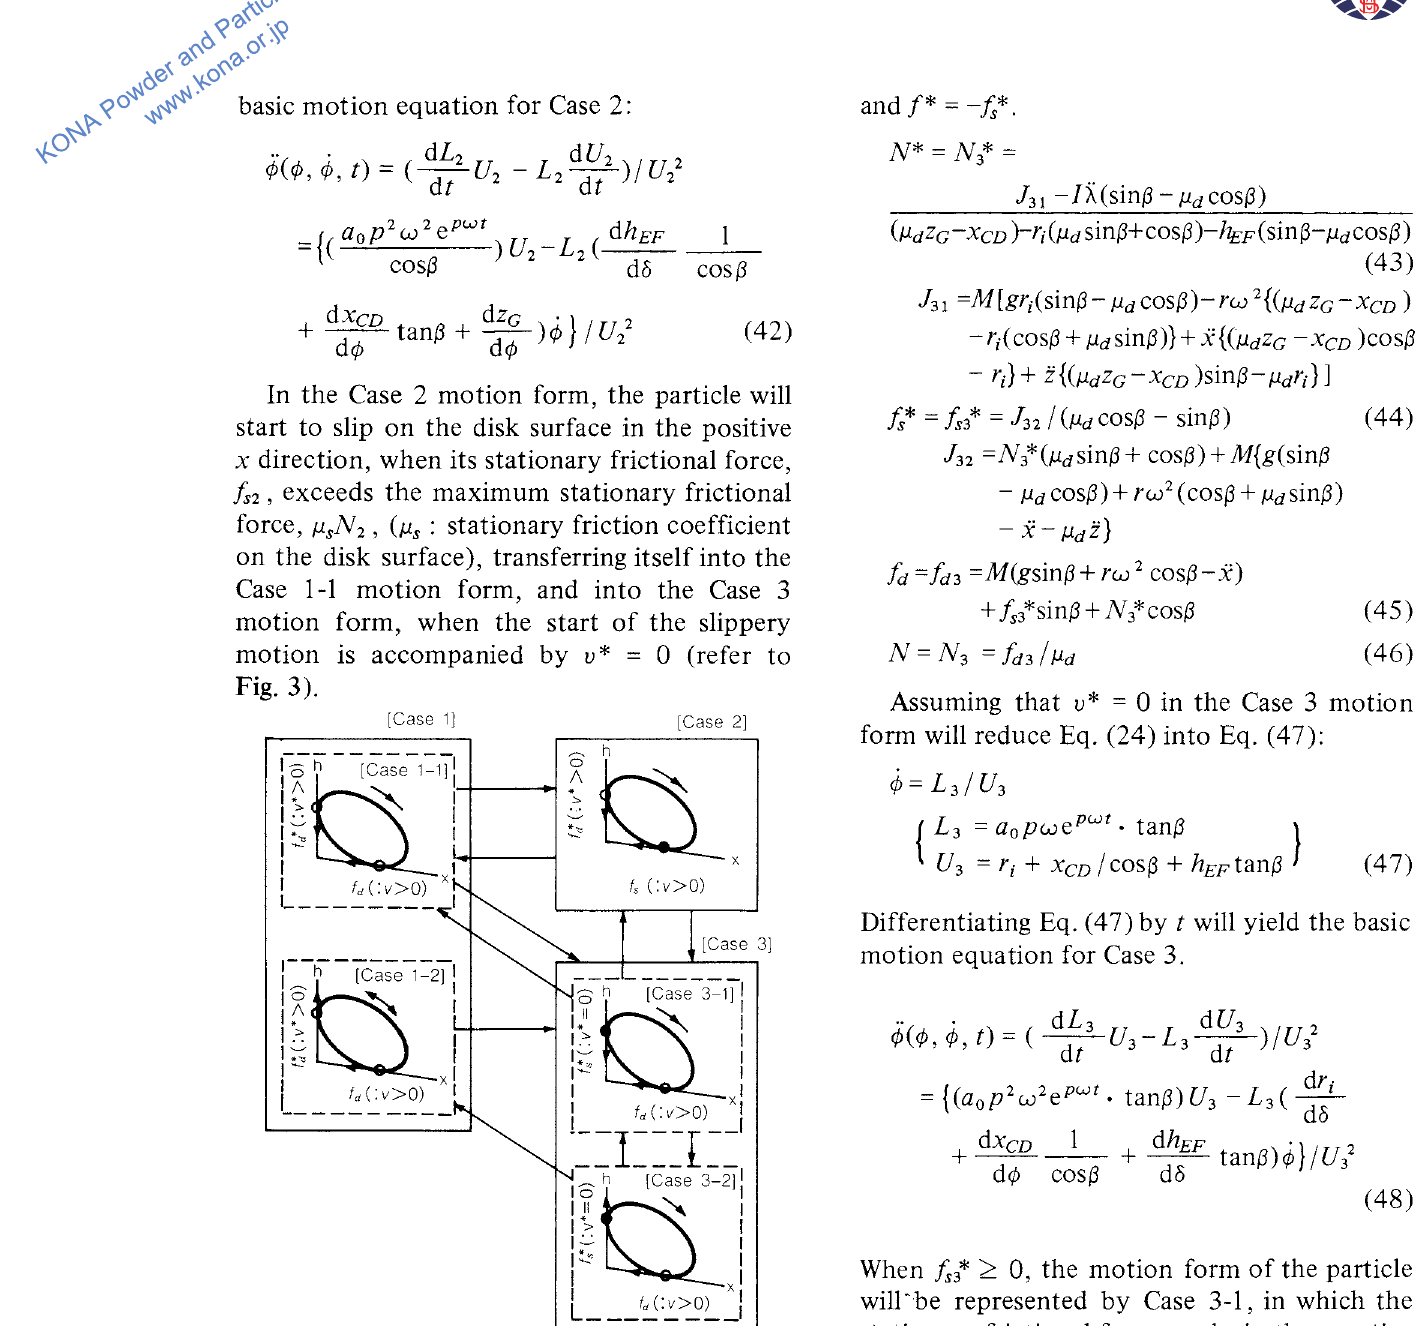
Fig. 3 The modes of particle's motion in the present